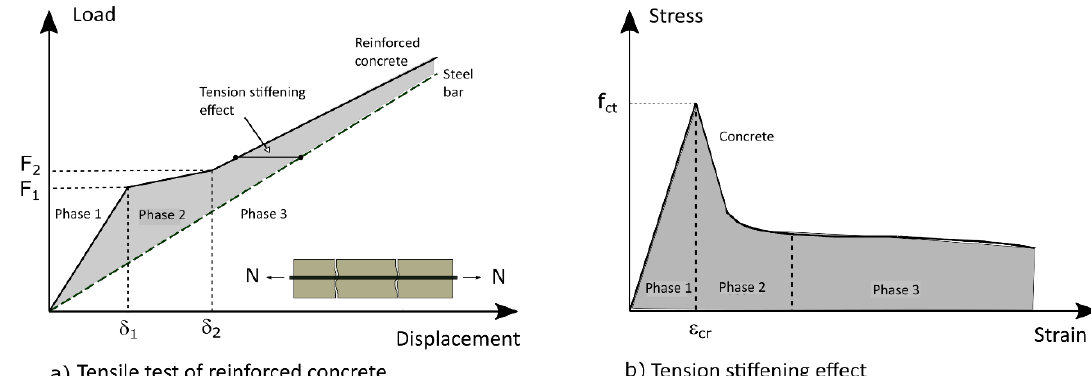
Figure 1. Stages of typical load-strain behavior of a tension stiffening element (a) and region where new cracks appear (b).